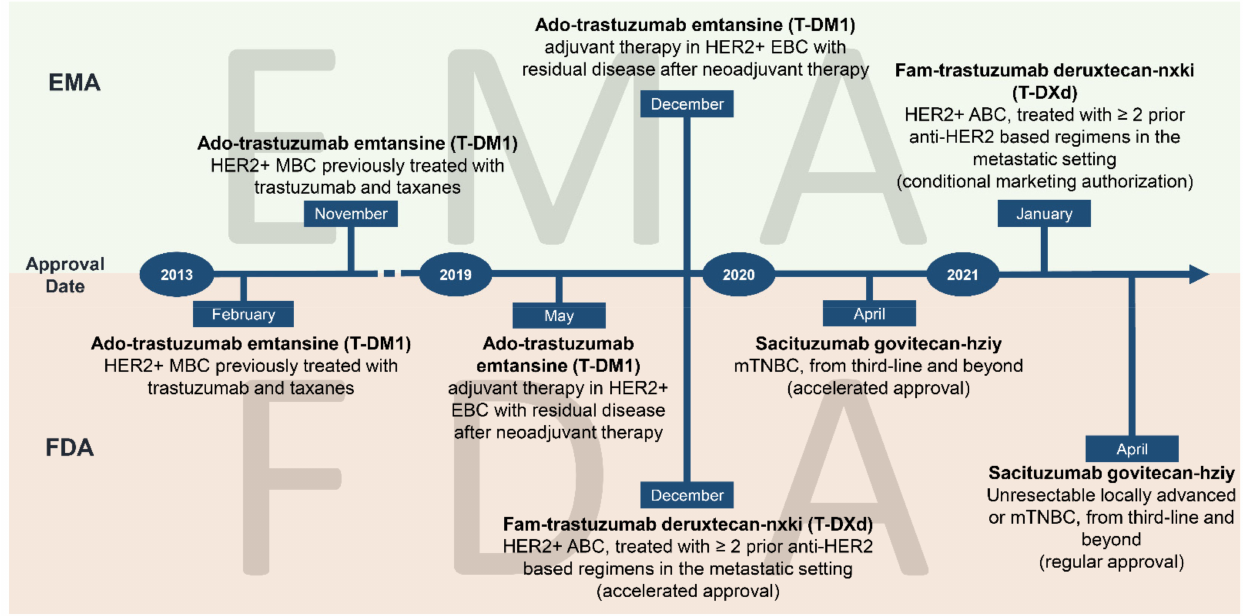
Figure 1. Temporal milestones of antibody–drug conjugates currently approved for the treatment of BC. Abbreviations: HER2, human epidermal growth factor receptor 2; T-DM1, trastuzumab emtansine; T-Dxd, trastuzumab deruxtecan; EMA, European Medicines Agency; FDA, Food and Drug Administration; 1MBC, metastatic breast cancer; 2EBC, early breast cancer; 3ABC, advanced breast cancer; mTNBC, metastatic triple-negative breast